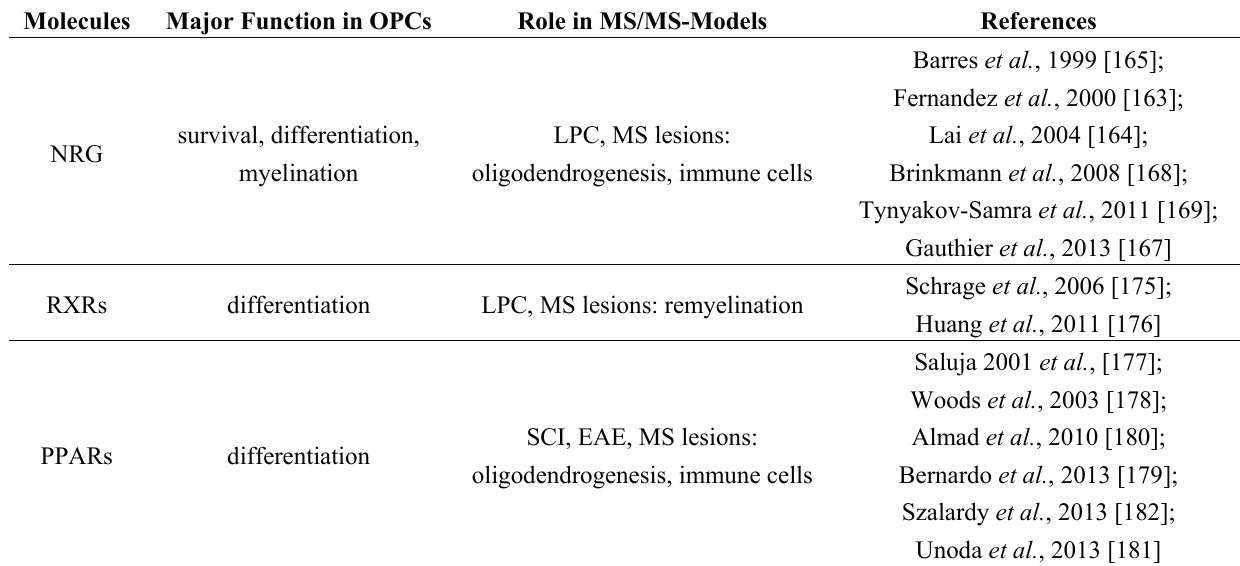
Table 3. Nuclear translocation of membrane